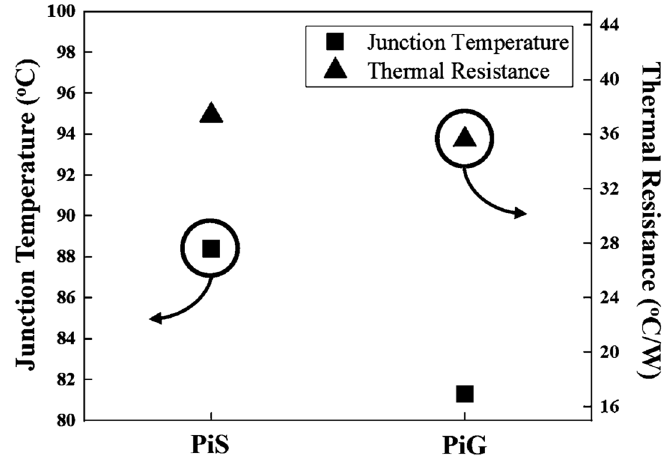
Figure 7. T j and R th of PiS WLED and PiG WLED. Table 4. Thermal properties of PiS WLED and PiG WLED.